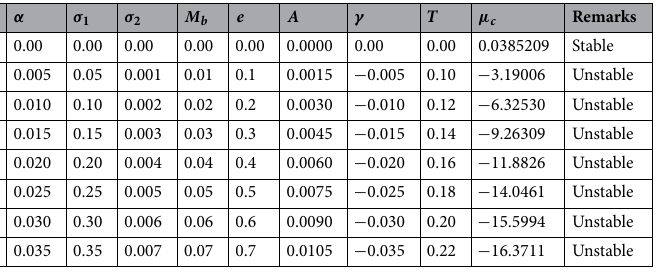
Table 6. Effects of varying parameters on the Critical Mass Value (µ c ) of the triangular libration points. 0.01215 ) . (µ = semi-major axis, Eccentricity of the orbits, Albedo effects, triaxiality, and the potential due to the belt of the problem under study. In the absence of the parameters mentioned above, the triangular libration points are stable (see Table 6). However, with the introduction of the parameters, the triangular libration points are unstable (see Table 6 and Figs. 10, 11, 12 and 13). When the parameters indicated above are increased, the critical mass value (µ c ) decreases, reducing the sta- bility region. The unstable behavior of the triangular libration points is depicted in Figs. 10, 11, 12 and 13. The critical mass value for the problem under investigation decreases as the parameters increase.